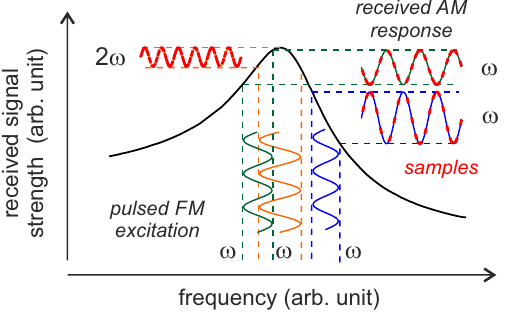
Figure 14. Pulsed FM/AM tracking loops with FM interrogation strategy and signed phase